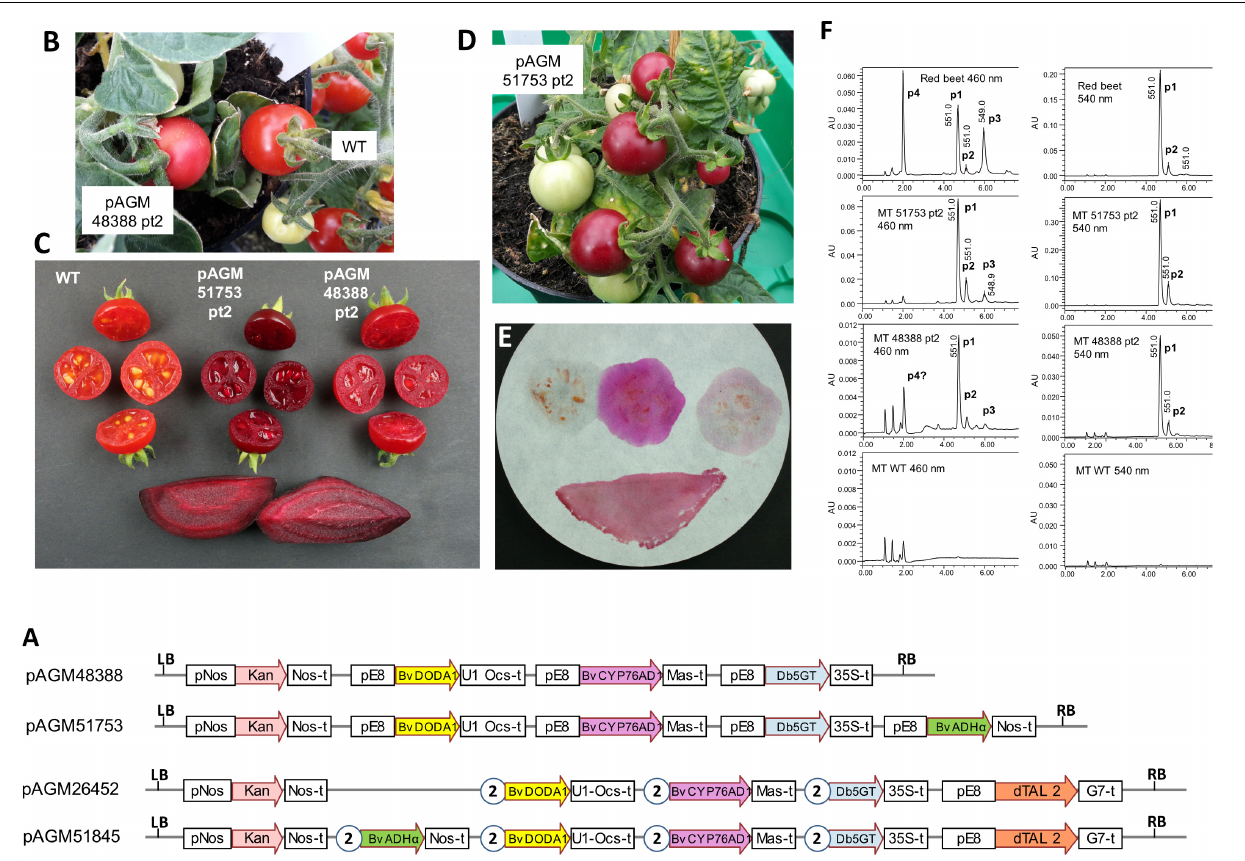
FIGURE 5 | Betalain biosynthesis by stable transformation of Micro Tom tomatoes. (A) Structure of the level 2 constructs for tomato transformation. pE8, fruit-specific tomato E8 promoter. All other legends as in Figure 3 . (B) Micro Tom pAGM48388 transformant 2. (C) Pictures of fruits of WT Micro Tom, pAGM51753 transformant 2, pAGM48388 transformant 2, and red beet slices as a control. (D) Micro Tom pAGM51753 transformant 2. (E) Fruits cut in half shown in (C) were blotted on filter paper in the order, from left to right, upper section: WT, pAGM51753 and pAGM48388. The lower part shows the blotting of a red beet slice. (F) LC/MS analysis of the extracts of fruits pAGM48388 and pAGM51753 transformants and of WT Micro Tom, and of a red beet as control. P1, betanin; P2, isobetanin, P3, neobetanin; P4, vulgaxanthin I. Note that the scale range (AU) is not the same for all